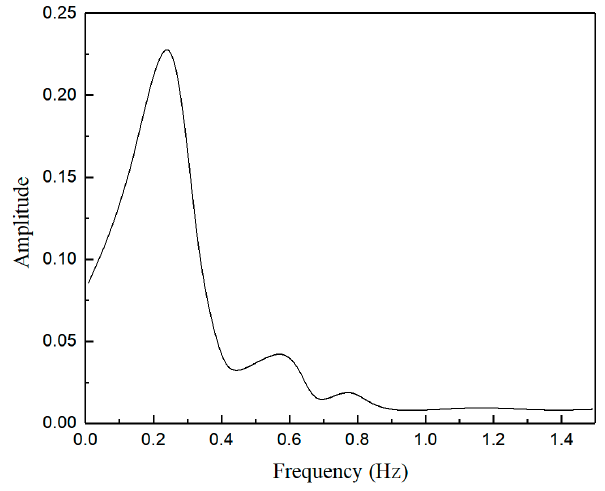
Figure 20. The oscillation frequency of the crossflow at monitoring point A through the gaps between the SEN wall and mold